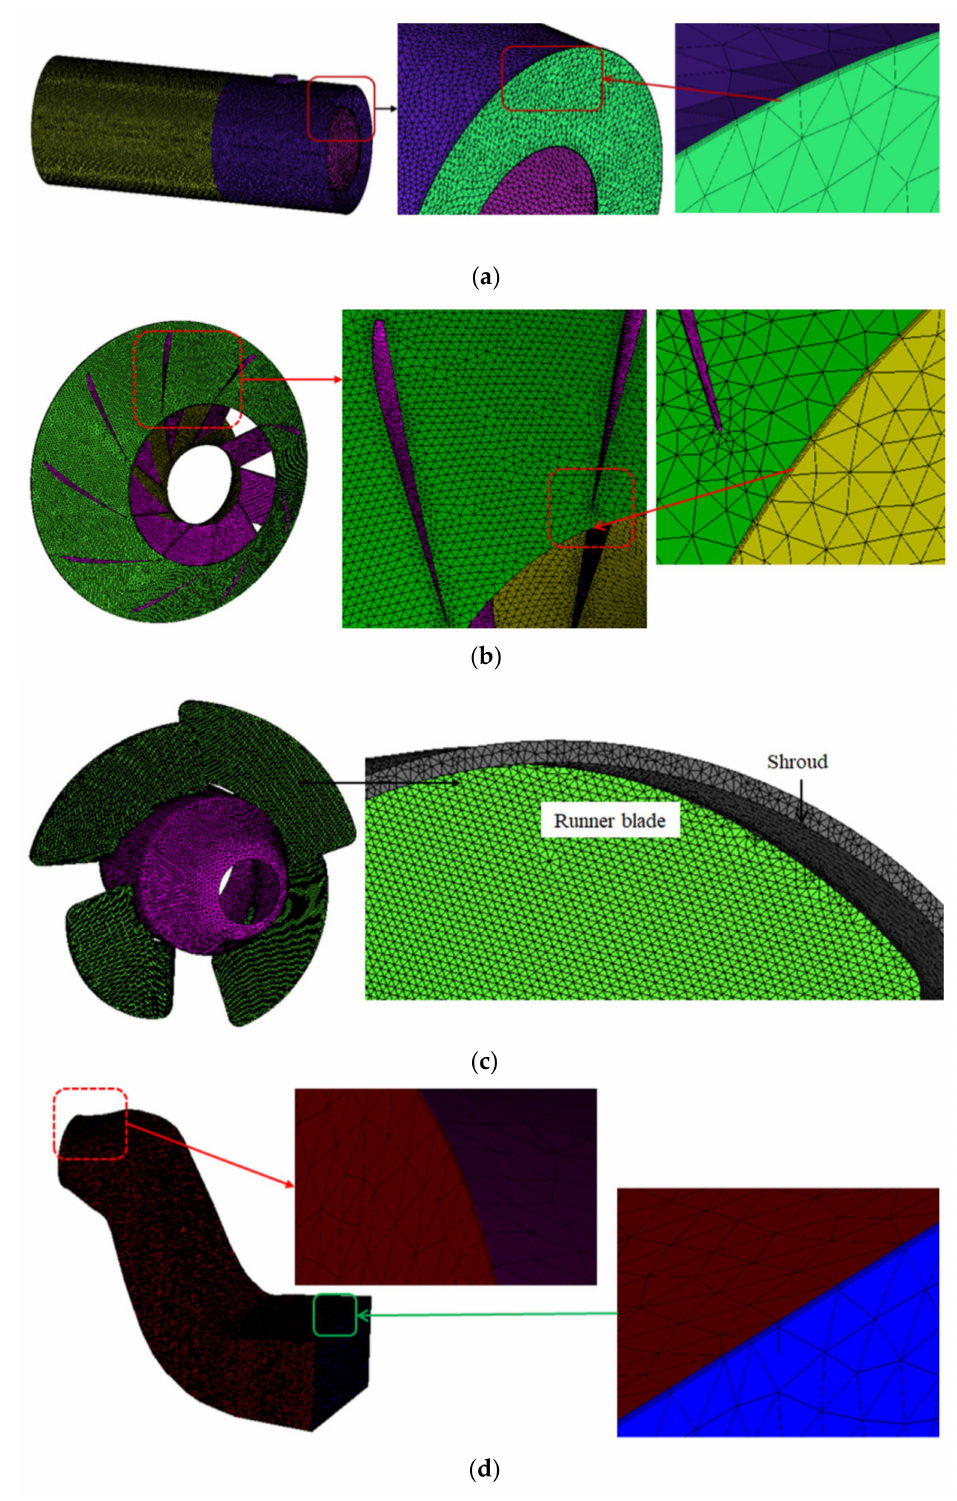
Figure 6. Unstructured prism grids: ( a ) inlet pipe and generator; ( b ) guide vane; ( c ) runner; ( d ) draft